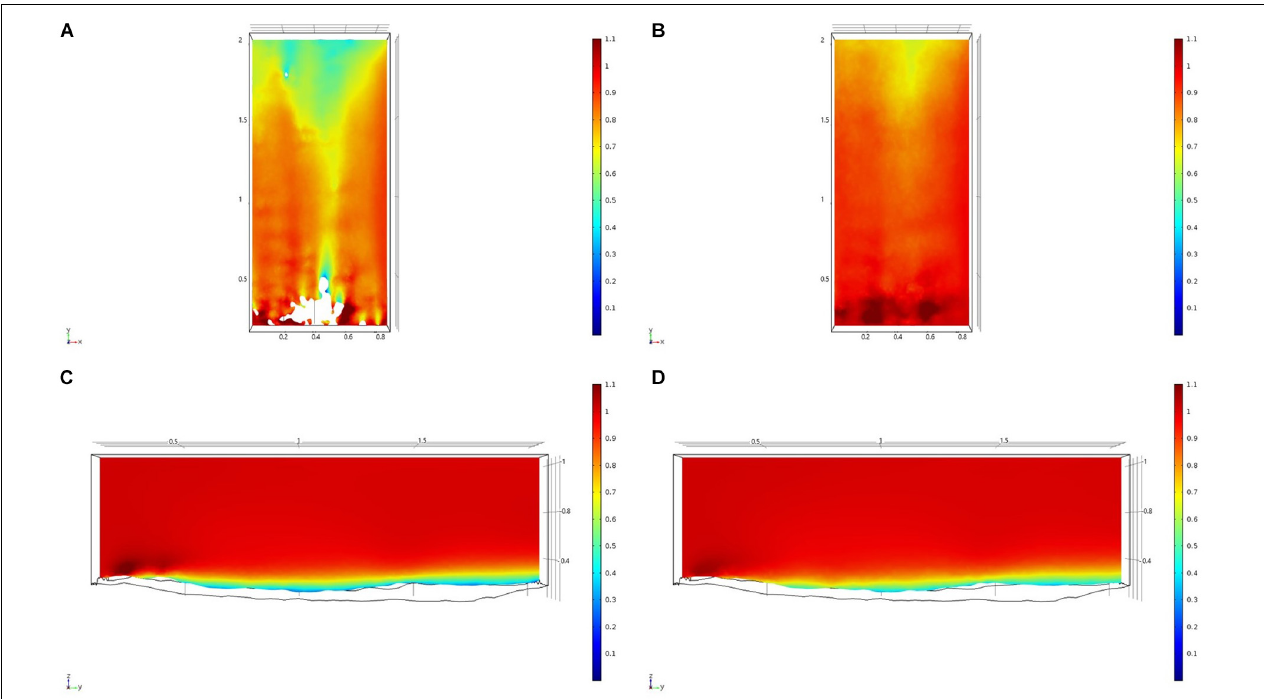
FIGURE 8 | Results of the fluid flow finite element analysis simulation for surface models for SWGL Study area visualized as two-dimensional plots (horizontal and vertical cross sections) of flow velocity magnitude (false-color scales m/s). (A,C) Surface model with sponges present. (B,D) Surface model with sponge structures removed. Scale in m with ambient flow of 1 m/s along the y